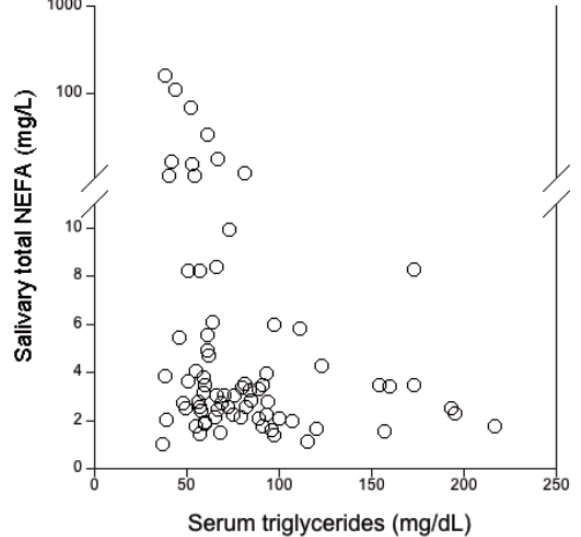
Figure 2. Correlation between the levels of serum triglycerides and salivary total NEFA in patients with CF ( n = 66). Spearman’s rank -order correlation: r s = -0.281, p = 0.014.